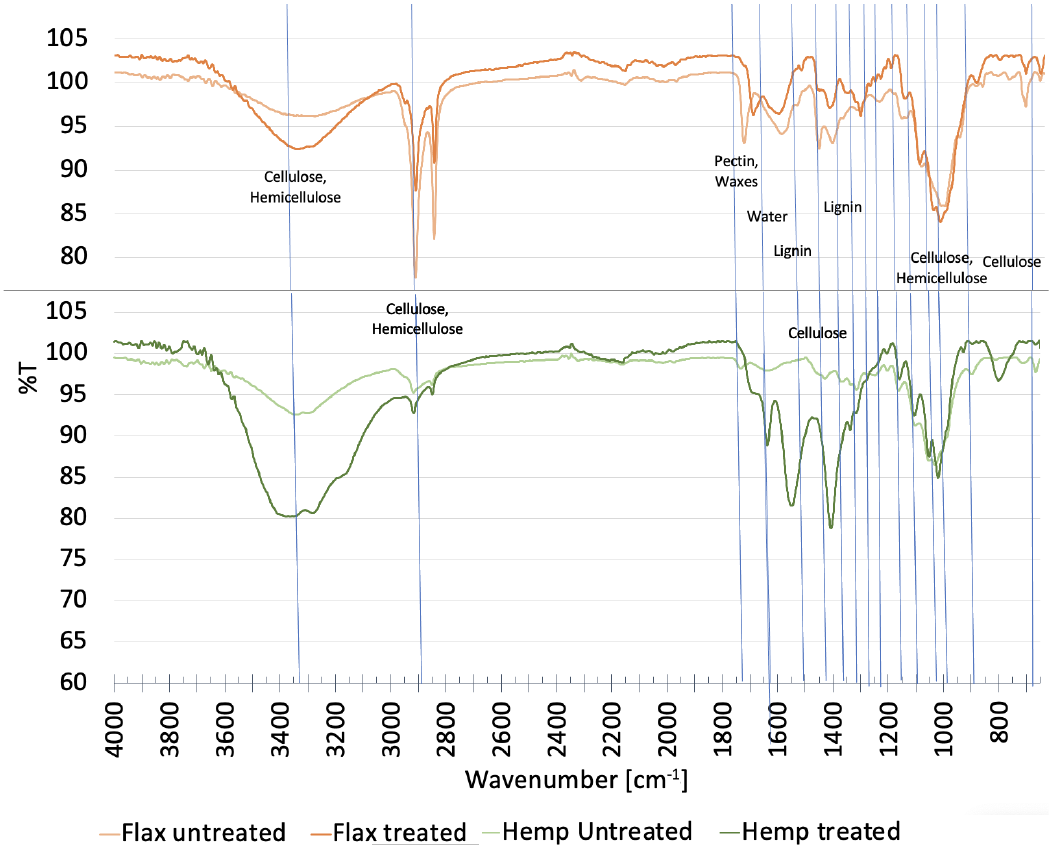
Figure 12. FTIR spectrums obtained for untreated and treated flax and hemp fibres.